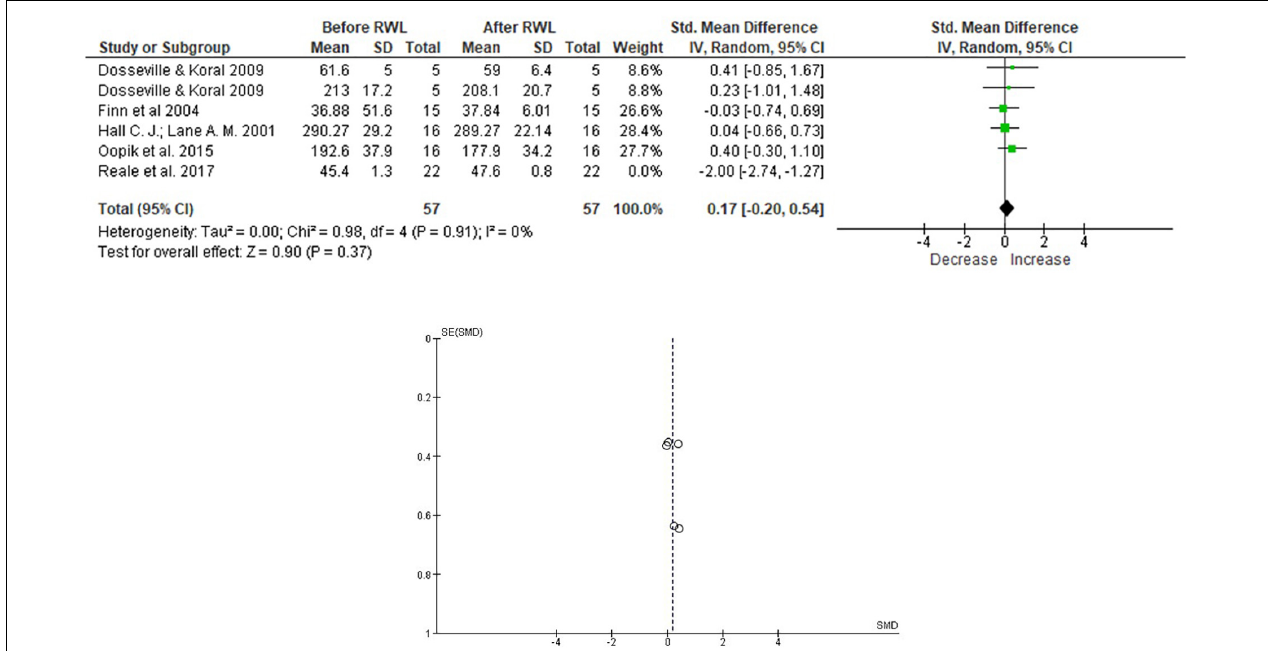
FIGURE 4 | Meta-analysis of the intermittent sprint work and power considering RWL studies with Olympic combat athletes.